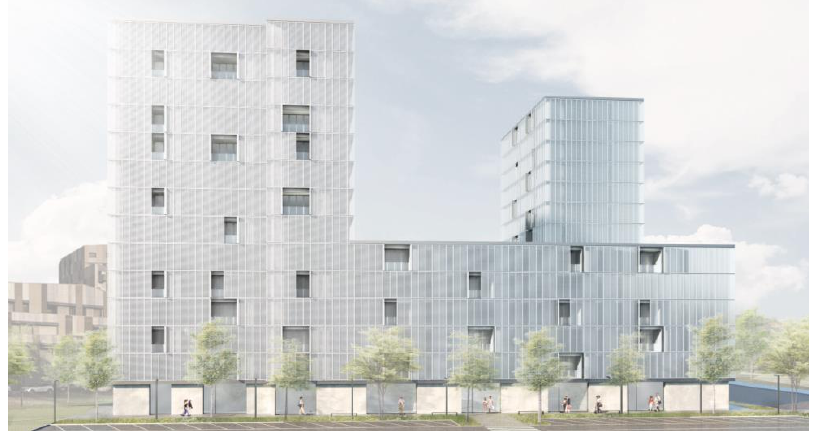
Figure 4. General view of the building articulated in differently oriented volumes for which a homogeneous façade layout was required.